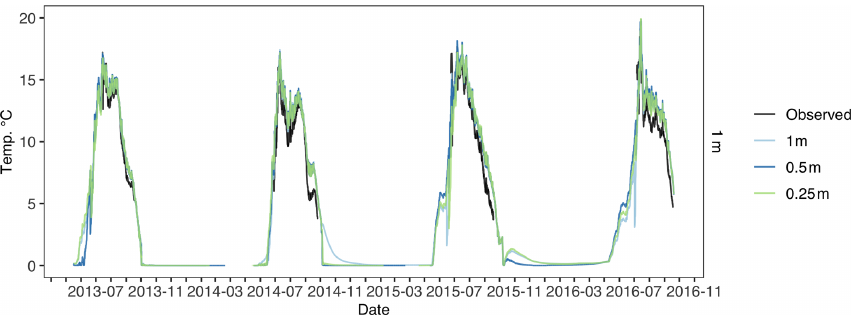
Figure D4. Toolik 1m water temperature across different water vertical resolution simulations. Observed water temperature is in black, 1m vertical resolution is in light blue, 0.5m vertical resolution is in blue, and 0.25m vertical resolution is in green.